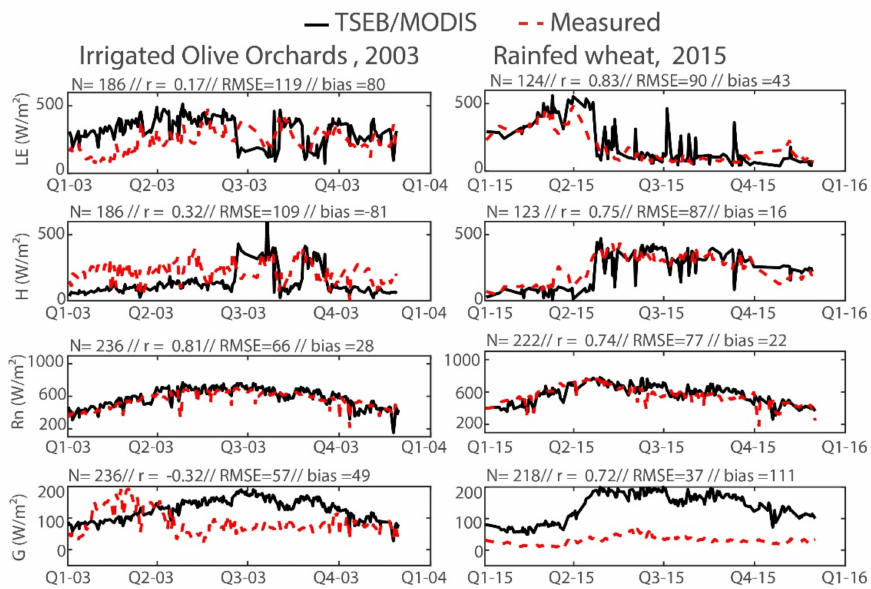
Figure 4. Seasonal variation of the four components of the energy budget (LE, H, Rn, and G) predicted by TSEB compared to measured values over two contrasted agricultural areas: irrigated olive orchards during 2003 and rainfed wheat during 2015. Q corresponds to a quarter (3 months). Statistical metrics RMSE and bias are expressed in W/m 2